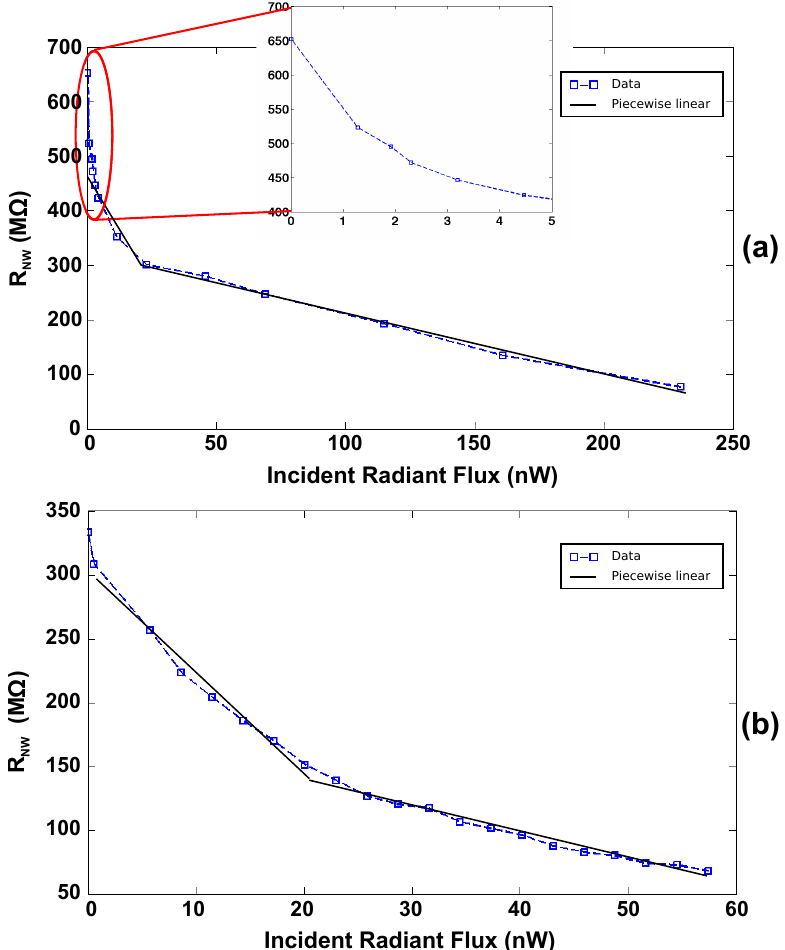
Figure 10. Variation of the R NW depending on the Incident UV-light Radiant Flux (IRF-UV) for ZnO-NW A ( a ) and ZnO-NW B ( b ) in the same M4N array. During experiments reported in ( a ), the M4N chip has been placed at 1cm and 6cm from the UV source, whereas in ( b ) the M4N chip has been fixed at